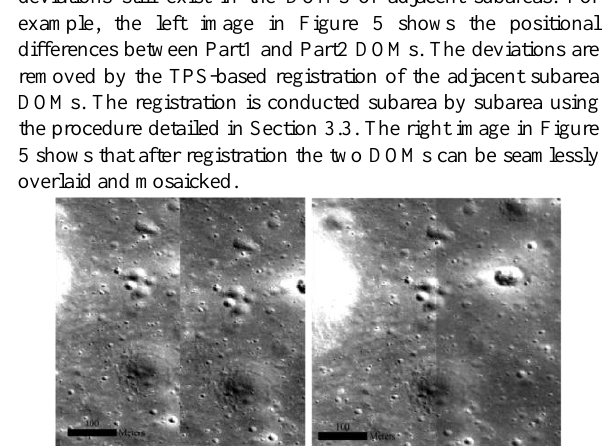
Figure 5. Comparison of the geometric deviation between the (right) TPS-based registration.